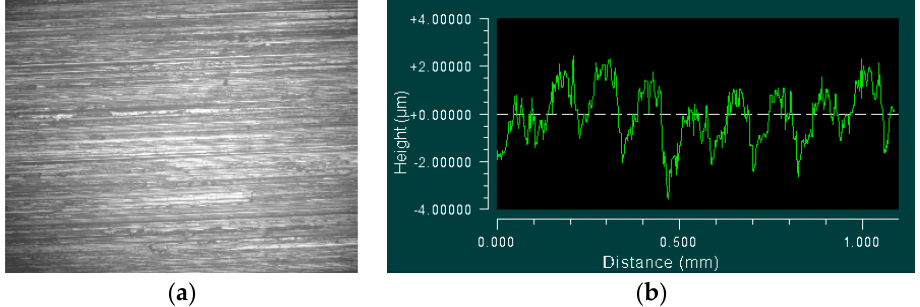
Figure 4. Measured surface and profile data ( a ) Specimen surface and ( b ) Measured profile curve.